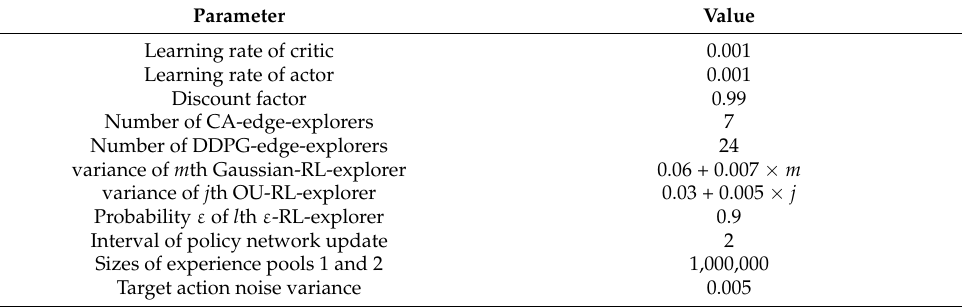
Table 1. Parameter